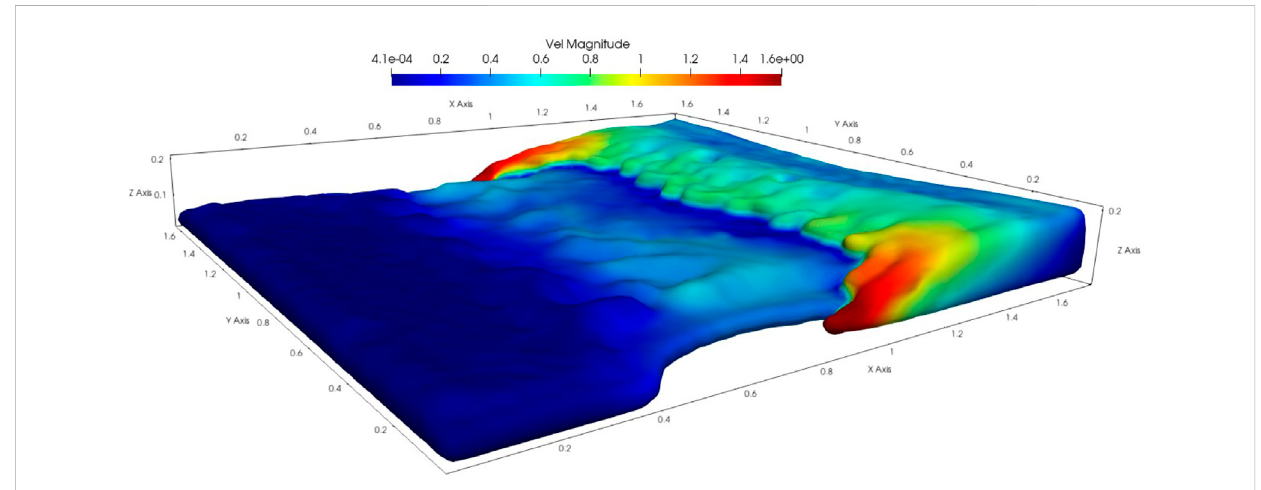
FIGURE 9 Test case shows the fl ow of pure fl